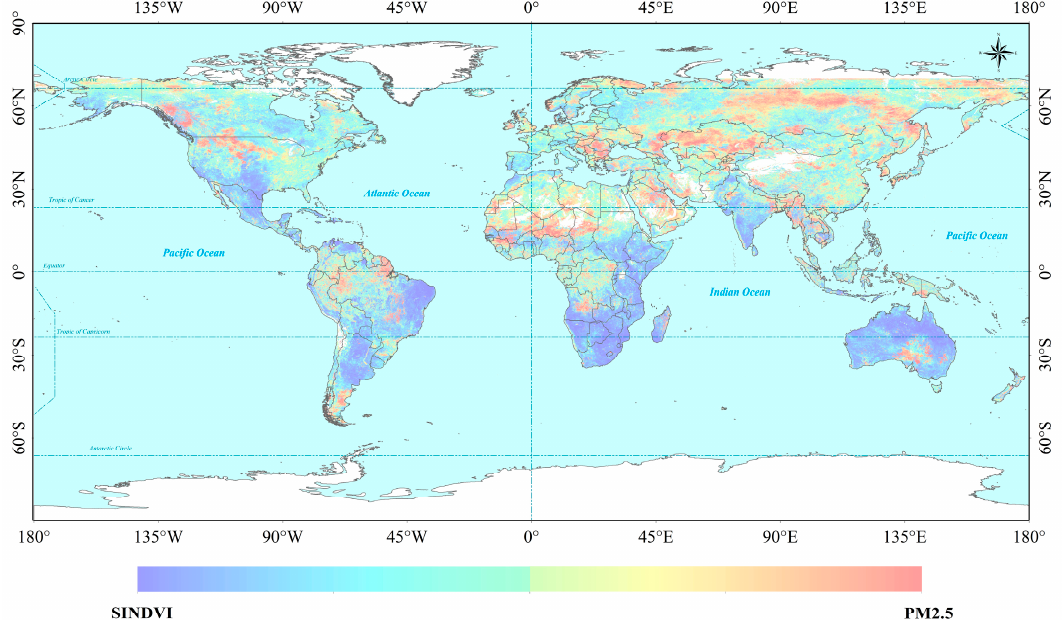
Figure 3. Partial correlation coefficient between LST with SINDVI (blue) and PM 2.5 (red) at a global scale. The blue color indicates SINDVI is the dominate factor of LST variation, while the red color indicates PM 2.5 is the dominate factor.